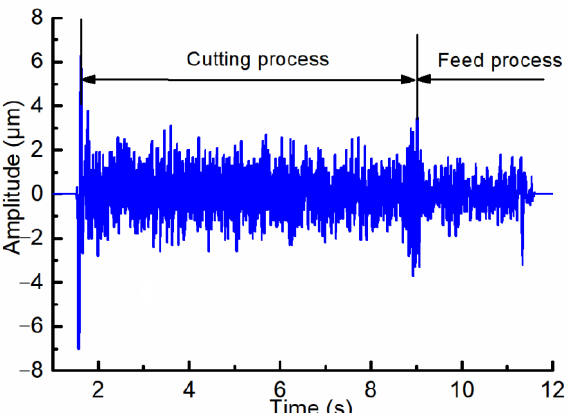
Figure 6. The displacement fluctuation of the direct drive feed system.